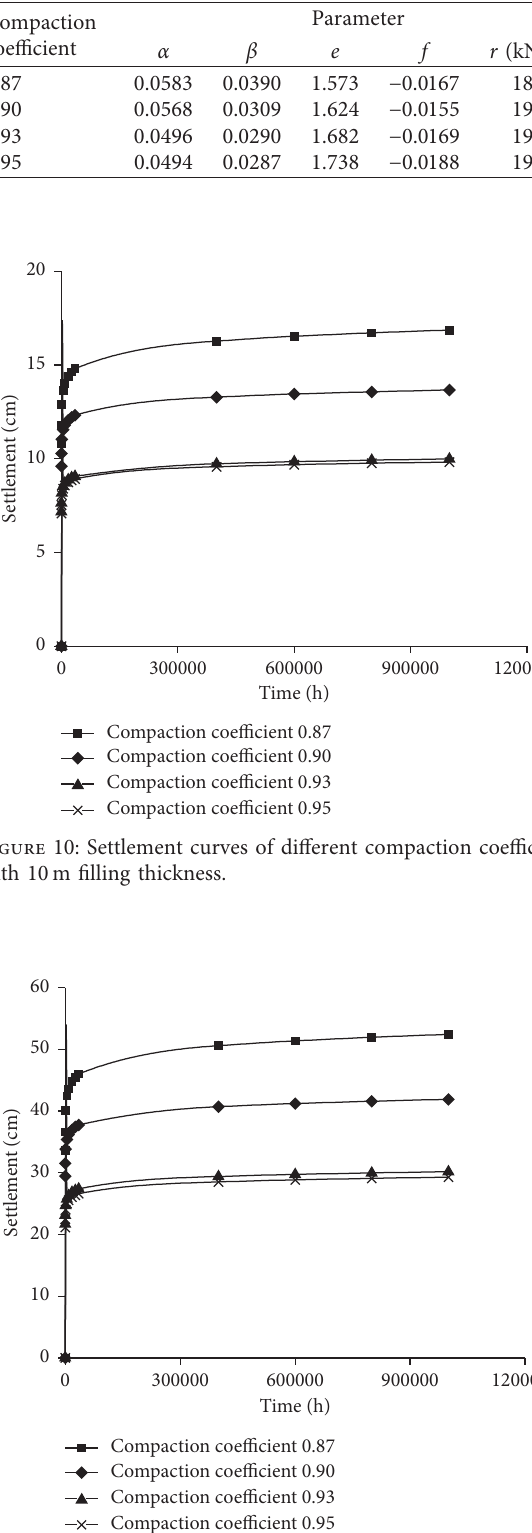
Figure 11: Settlement curves of different compaction coefficients with 20 m filling